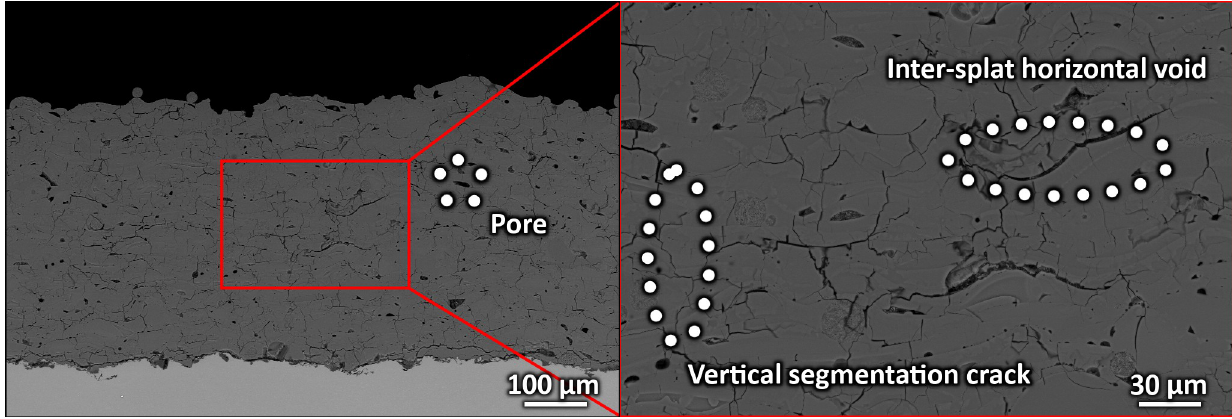
Fig 4. Microstructure of the HA coatings produced on Ti6Al4V substrate (sample T 320 shown). Given the thermal spray production method, the coating contained some pores, voids and cracks. The magnified inset shows network of inter-splat voids forming by improper droplet spreading and contact, as well as vertical segmentation cracks in the coating, a consequence of internal stresses alleviation upon cooling to room temperature.